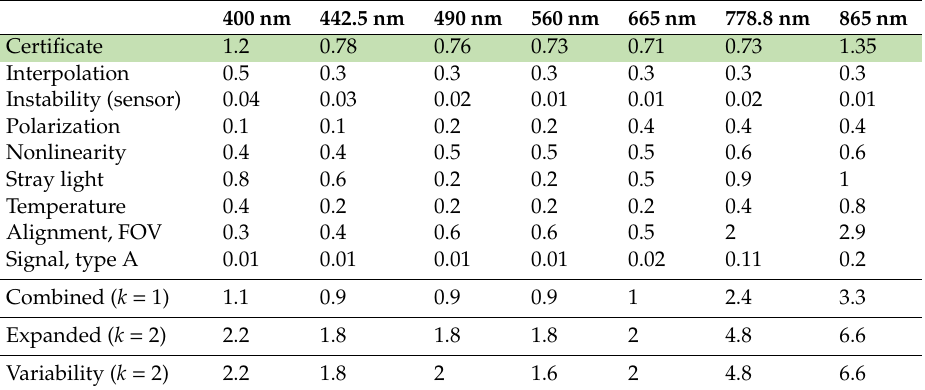
Table 5. Relative uncertainty budget for the radiance of blue sky (in percent), based on the spread of individual sensors pointing to the same target during the outdoor comparison. Data highlighted in green are not used for combined and expanded uncertainties. Last row: Relative experimental variability of sensors evaluated from the results of field comparisons.